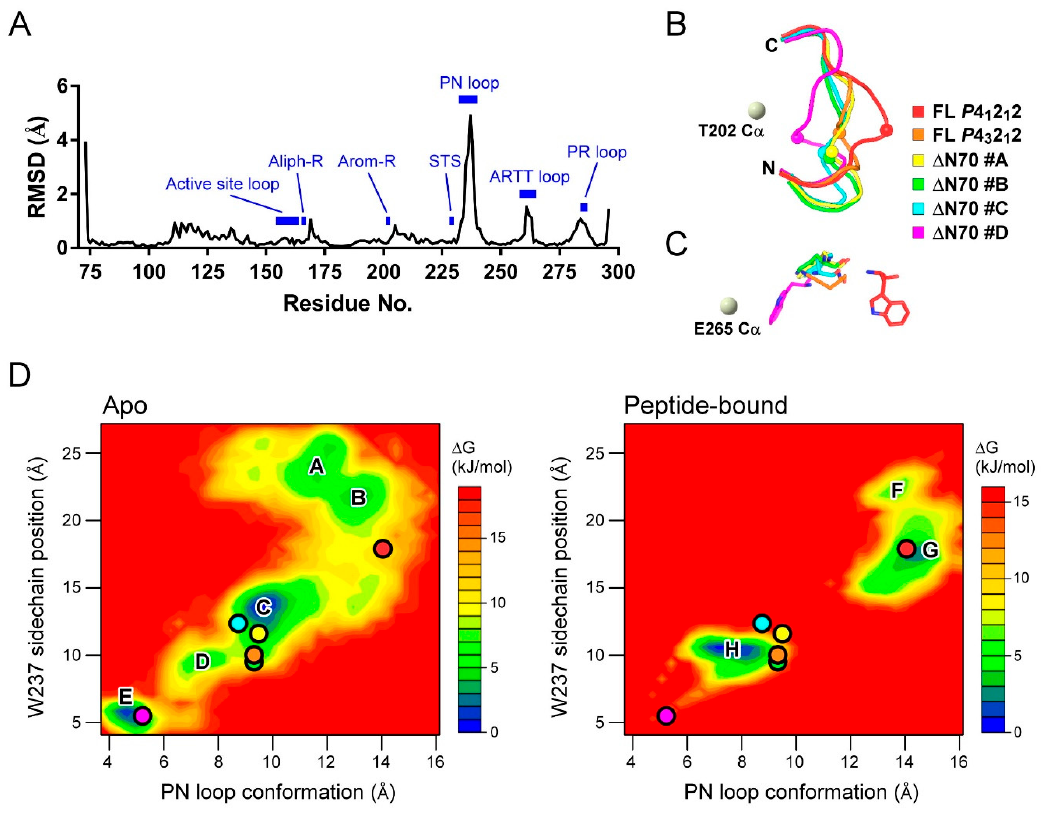
Figure 5. MD analysis of PN loop dynamics. ( A ) Per-residue averaged root-mean-square deviation (RMSD) among available XopAI crystal structures. Those regions of interest are marked as blues bars and labeled. ( B ) Observed PN loop conformations in the full-length (FL) and ∆ N70 crystals. The position of W237 on the PN loop is shown as a bead model. As a reference, the location of Thr202 C α atom is depicted as a gray bead. Protein backbones are colored distinctly for the various conformations as follows: FL P 4 1 2 1 2 (red), FL P 4 3 2 1 2 (orange), ∆ N70 monomer A (yellow), ∆ N70 monomer B (green), ∆ N70 monomer C (cyan), and ∆ N70 monomer D (magenta). ( C ) Observed W237 positions and conformations in the crystals; the view of this panel is rotated along the horizontal axis by 90 ◦ counterclockwise from that of ( B ). The carbon atoms of residue W237 are colored distinctly according to ( A ). The oxygen and nitrogen atoms are colored in red and blue, respectively. As a reference, the location of the E265 C α atom is depicted as a gray bead. ( D ) energy landscapes depicting the motions of the PN loop and residue W237 in the absence (apo) and presence of Arg peptide (peptide-bound). The depth of the three-dimensional energy landscape indicates the value of the conformation free energy. The free energy is given in kJ / mol and is indicated by the color code shown in the figure. The conformation state of the observed structures is marked with colored circles. The color code for the circles is the same as that in ( B , C